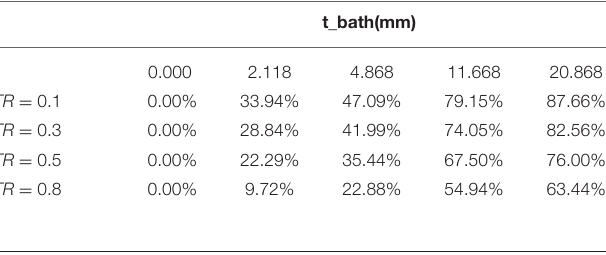
FIGURE 4 | Ratio of parallel conductance to the total conductance for various lumen diameters for 5-5-5 guidewire based on model prediction. There is